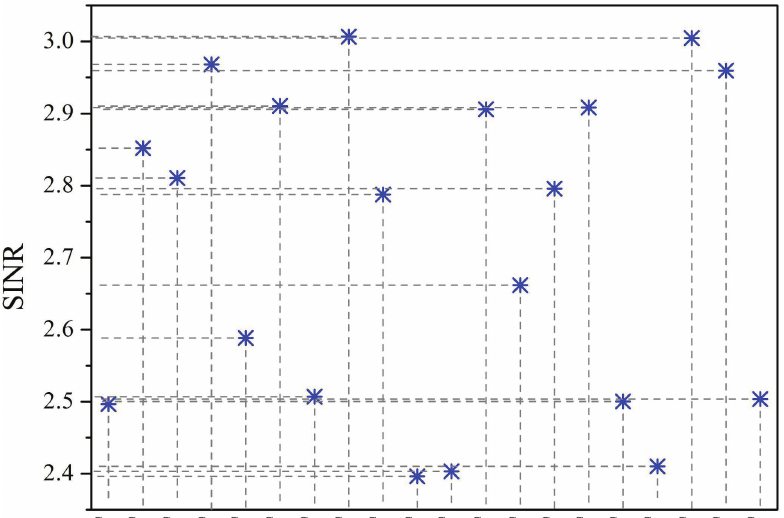
Figure 4. SINR of each